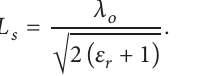
a quarter or odd multiple of quarter of the guided wavelength.